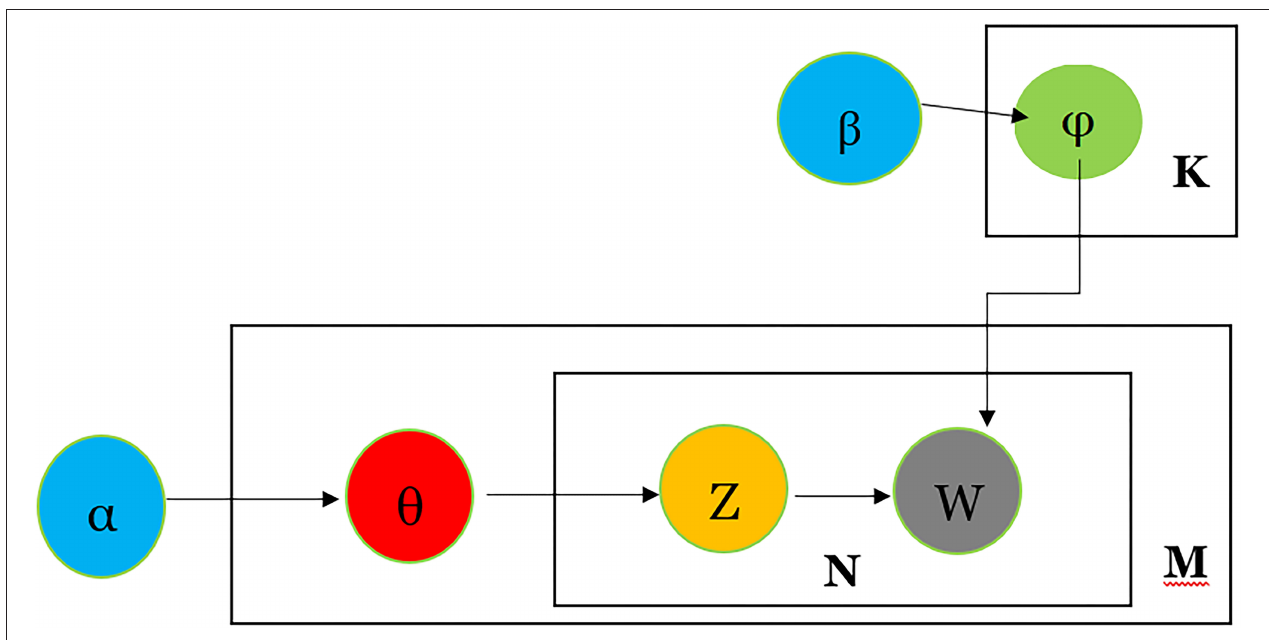
FIGURE 1 | Plane notation of the LDA Topic